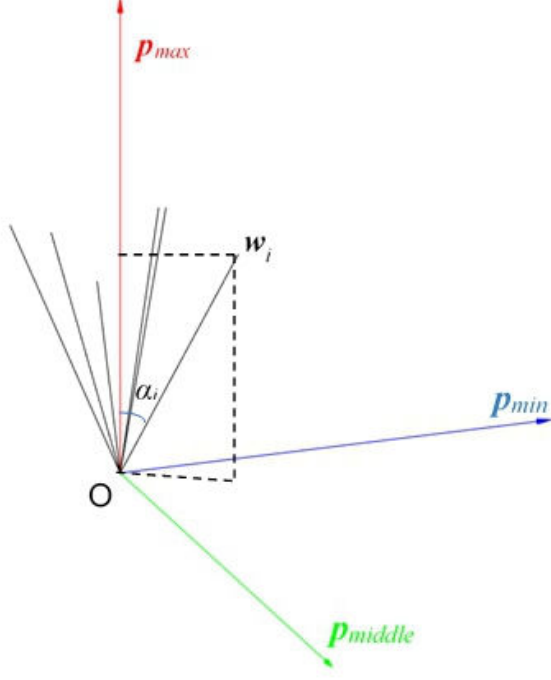
Figure 5. Physical interpretation of the SVD of the matrix W